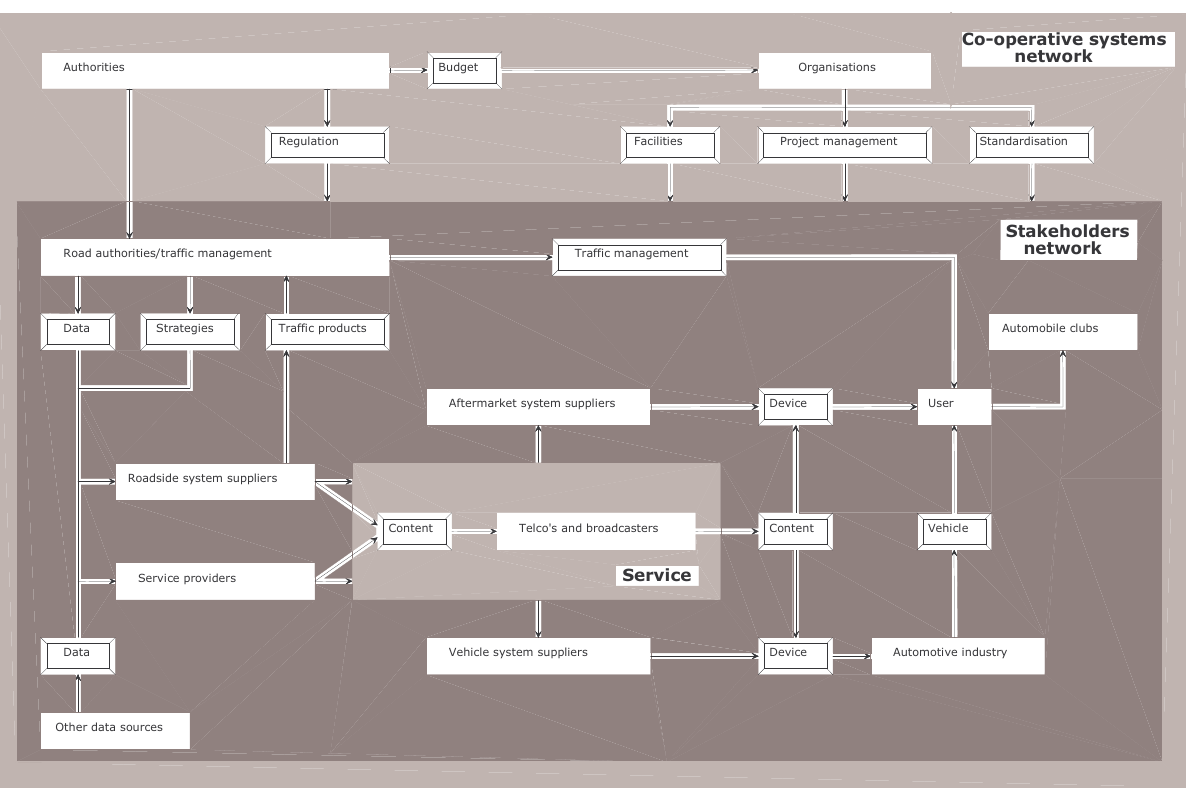
Figure 1. Stakeholder roles and